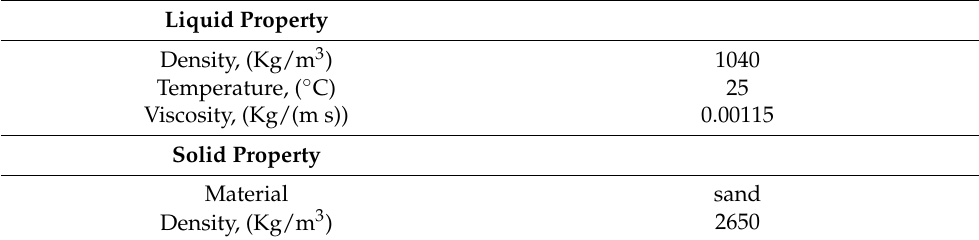
Table 4. Simulation parameters employed in the current